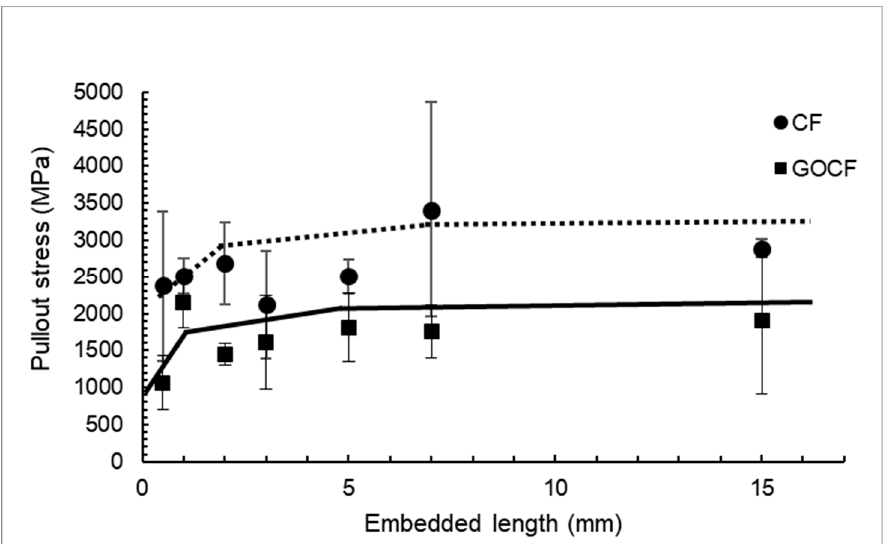
Figure 11. Pullout stress of both curaua fibers, CF and GOCF, versus epoxy embedded length curves.